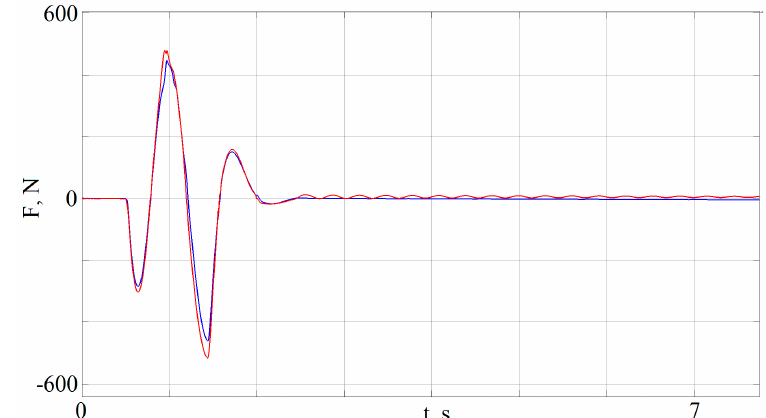
Figure 17. Desired force on the rod generated by the high level PID controller (red) and actual force on the rod (blue).